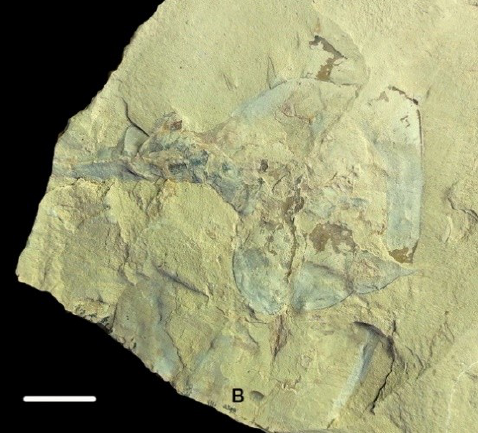
Figure 14. Shenzianyuloma yunnanense nov. gen. nov. sp. Holotype. Sample 1 of 6 / 25 / 2019; IGM 5008. B , Epifaunal brachiopod Diadonga pista . Scale bar 1 cm.